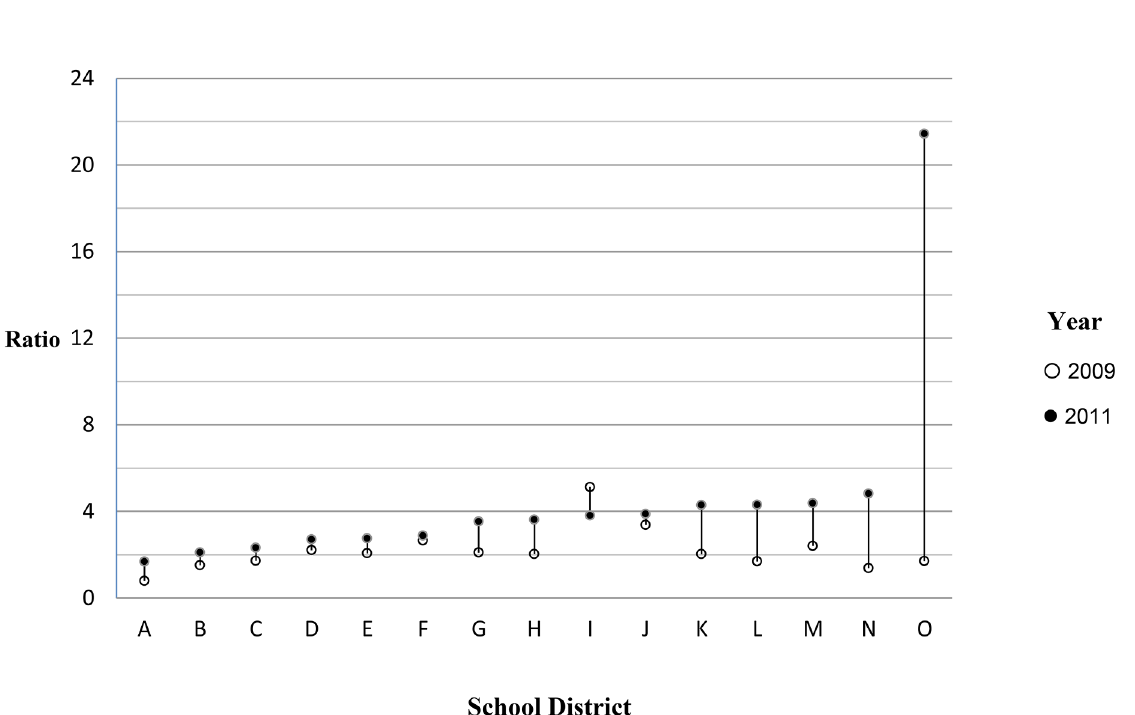
Fig 2. Change in LFS:HFS ratio of planned servings from 2009 to 2011, by school district. a. LFS:HFS ratio = Lower Fat/less added Sugar: Higher Fat/ more added